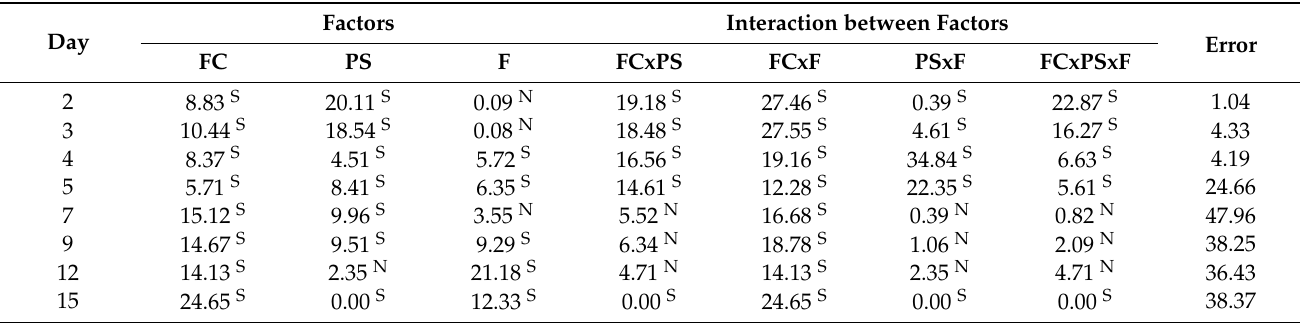
Table 3. The influence percentage of individual factors and their interactions affecting the mold growth on PLA composites.